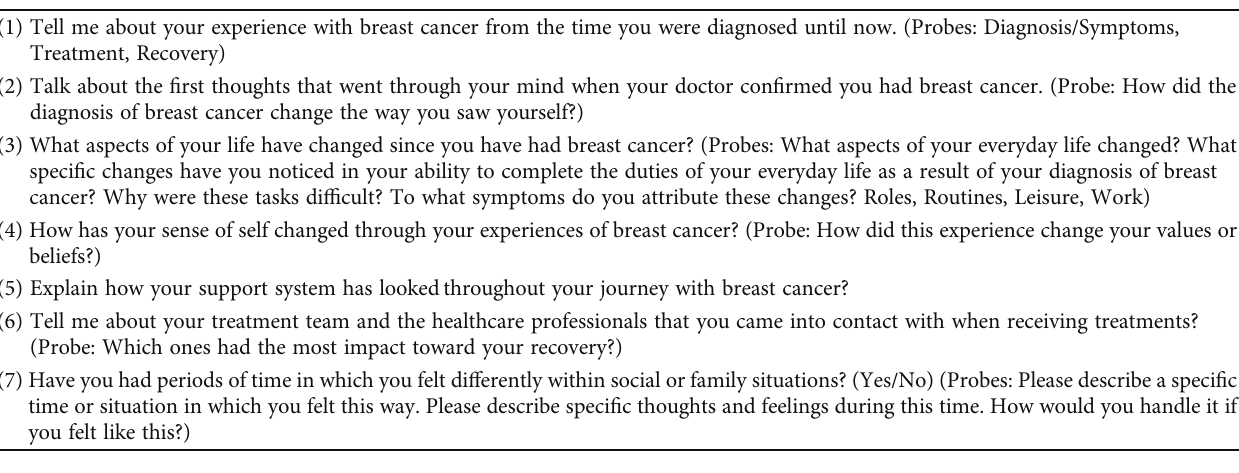
Table 1: Interview